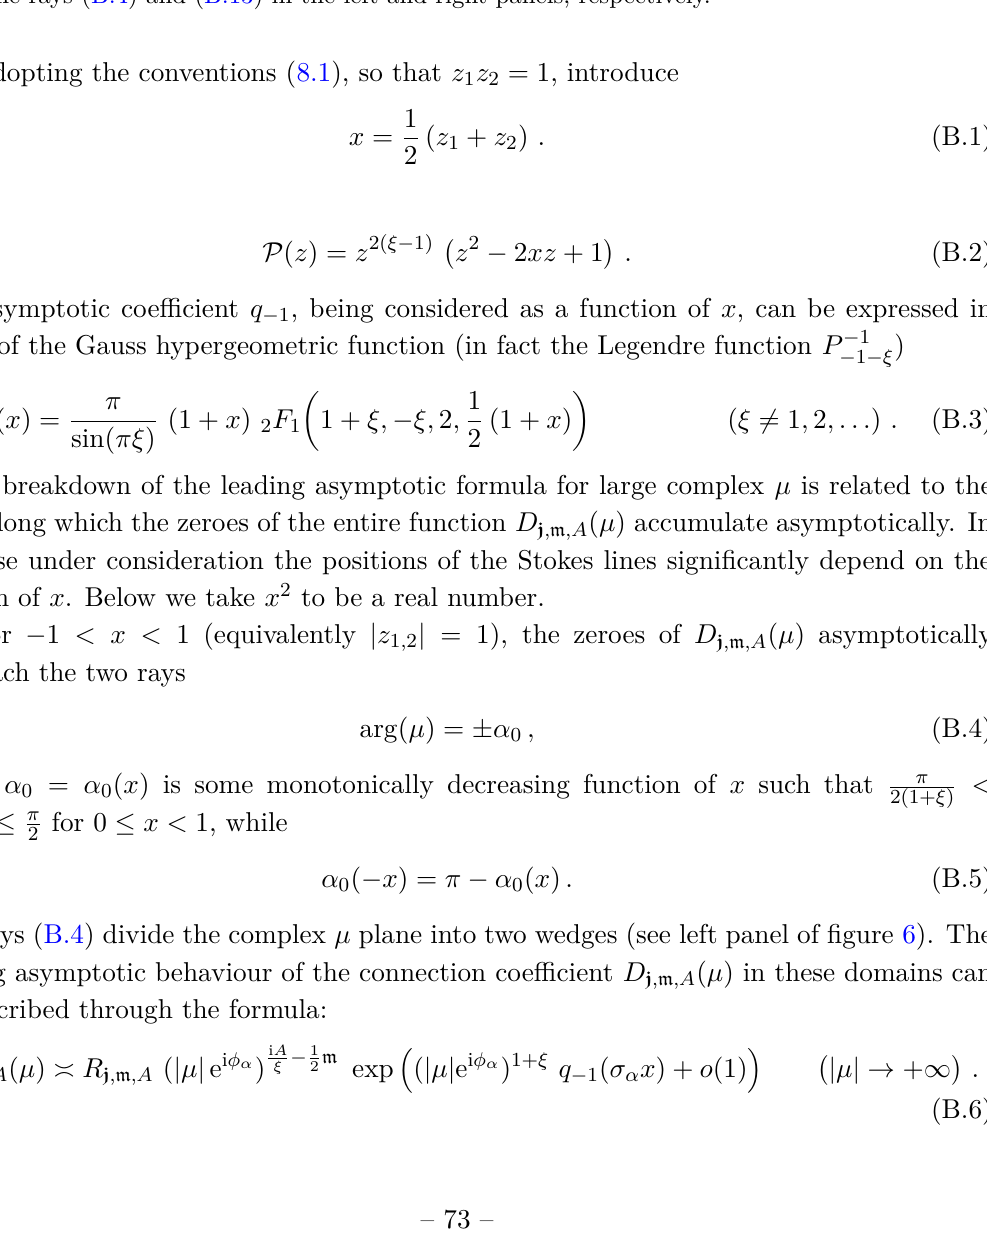
Figure 6 . The typical pattern of zeroes of D j , m ,A ( µ ) in the complex µ plane for the two cases 0 < x < 1 and x > 1 . The numerical data was obtained for j 1 = j 2 = m = 0 , A = i the connection coefficient is expressed in terms of the parabolic cylinder function. The dashed lines mark the rays (B.4) and (B.13) in the left and right panels,